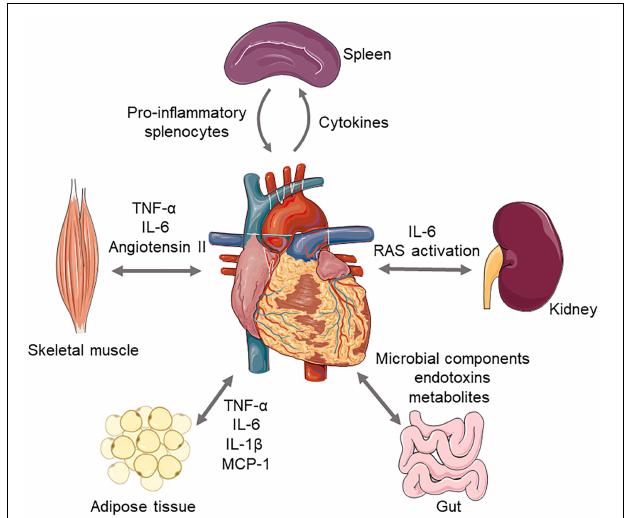
FIGURE 1 | Interaction between heart and extracardiac organs. Heart failure and inflammatory responses are mutually reinforced with each other. Upon injury, splenic monocytes could mobilize and accumulate in myocardium to induce cardiac injury. Stimulus such as elevated circulating inflammatory cytokines, adipokines, and peripheral organs hypoperfusion could induce renal dysfunction, gut microbiota disorder, and skeletal muscle catabolism, which further exacerbate cardiac